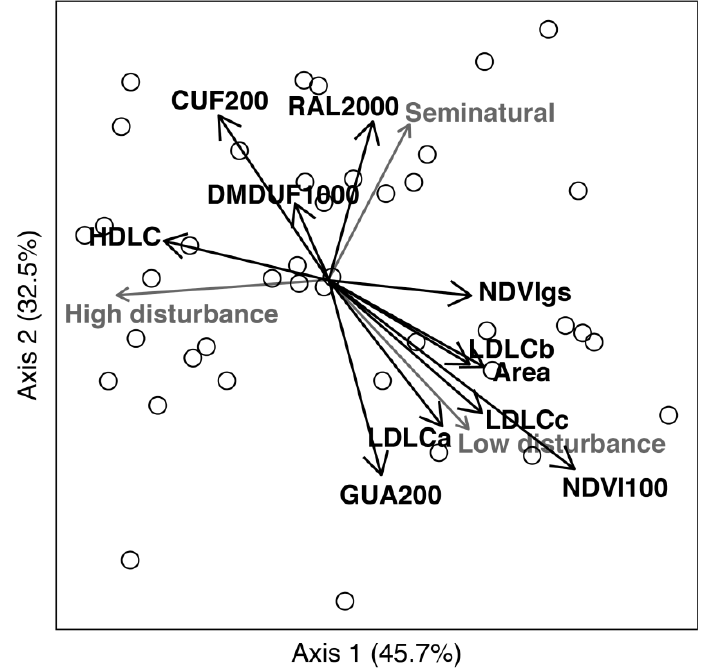
Figure 3. NMS ordination plot showing the ordination of sampling sites (hollow circles; n = 41) after correction of species classification. Black vectors represent the environmental variables and grey vectors represent the CWM of the three functional groups (high disturbance, low disturbance, and seminatural). The first two axes explain, respectively, 45.7% and 32.5% of the variance. Environmental variables: Area is the area of each green space; NDVIgs is the normalized difference vegetation index (NDVI) value for the green space centroid; NDVI100 is the NDVI value for a 100 m buffer around each green space centroid; CUF—Continuous urban fabric (S.L.: >80%); DMDUF—Discontinuous medium density urban fabric (S.L.: 30%–50%); GUA—Green urban areas; RAL—Railways and associated land; HDLC—High disturbed land covers; LDCLa—Low disturbed land covers (1000 m buffer); LDCLb—Low disturbed land covers (1500 m buffer); LDCLc—Low disturbed land covers (2000 m buffer). Only significant variables are shown to prevent overcrowding. See species code names in Annex I.